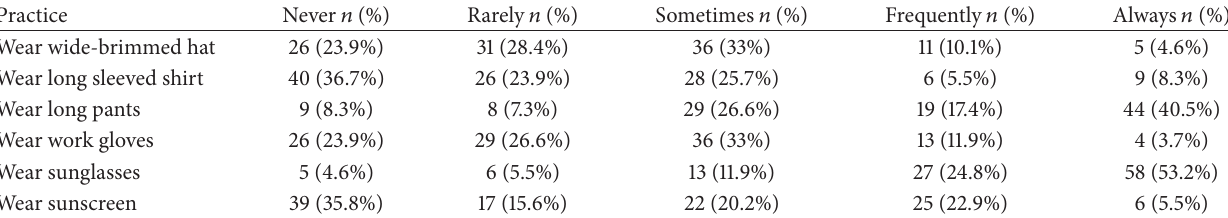
Table 1: Frequencies and percentages of sun protection